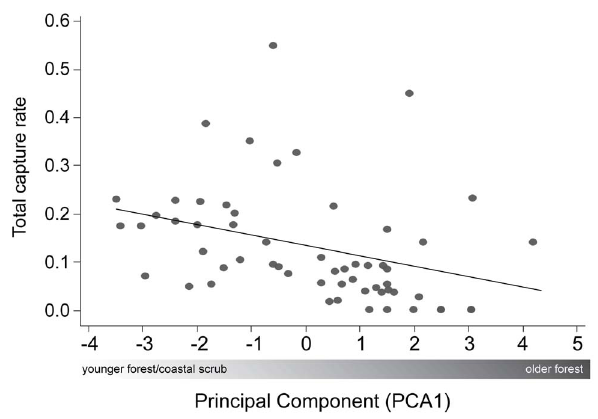
Figure 3. Linear regression between the first principal compo- nent (PCA1) and hourly capture rate of all study species ( P =0.013, adj. R 2 =0.09). Positive PCA1 values are associated with mature forest habitat types. Tortuguero, Costa Rica, 2008.